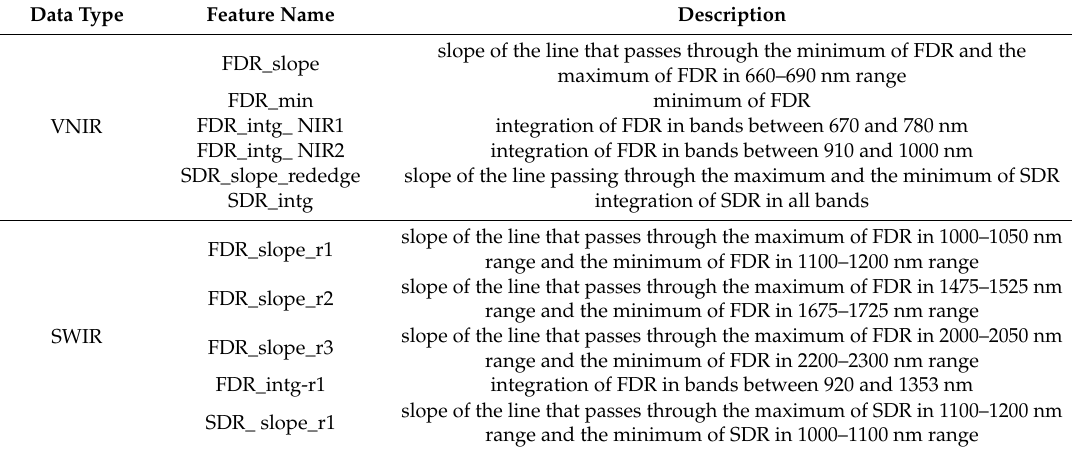
Table A5. Derivative features were extracted from each first derivative (FDR) and second derivative (SDR) spectrum.